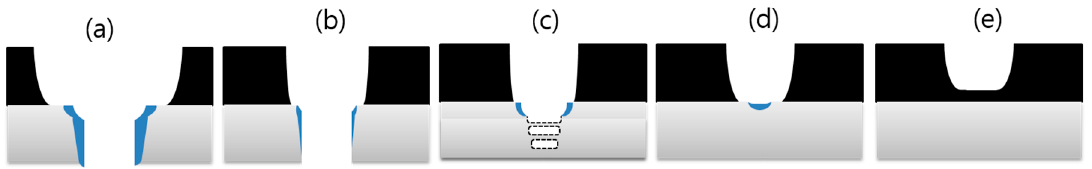
Figure 15. Five types of physical characteristics with cross sectional view. ( a ) full penetration of electrodes; ( b ) full penetration of electrodes with narrower top width; ( c ) partial penetration of electrodes; ( d ) partial penetration and shallow molten zone; ( e ) partial removal of active electrode material.